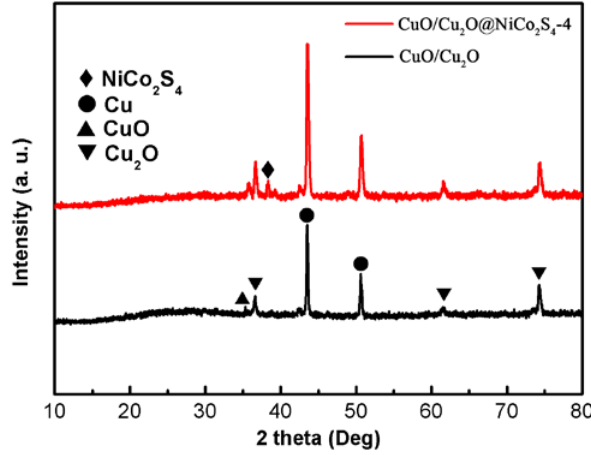
Figure 2. X-ray diffraction patters of the as–prepared CuO/Cu 2 O/Cu and CuO/Cu 2 O@NiCo 2 S 4 -4. In order to characterize the structure and surface morphology of hierarchical CuO/Cu 2 O@NiCo 2 S 4 -4 composite, scanning electron microscopy (SEM) and transmission electron